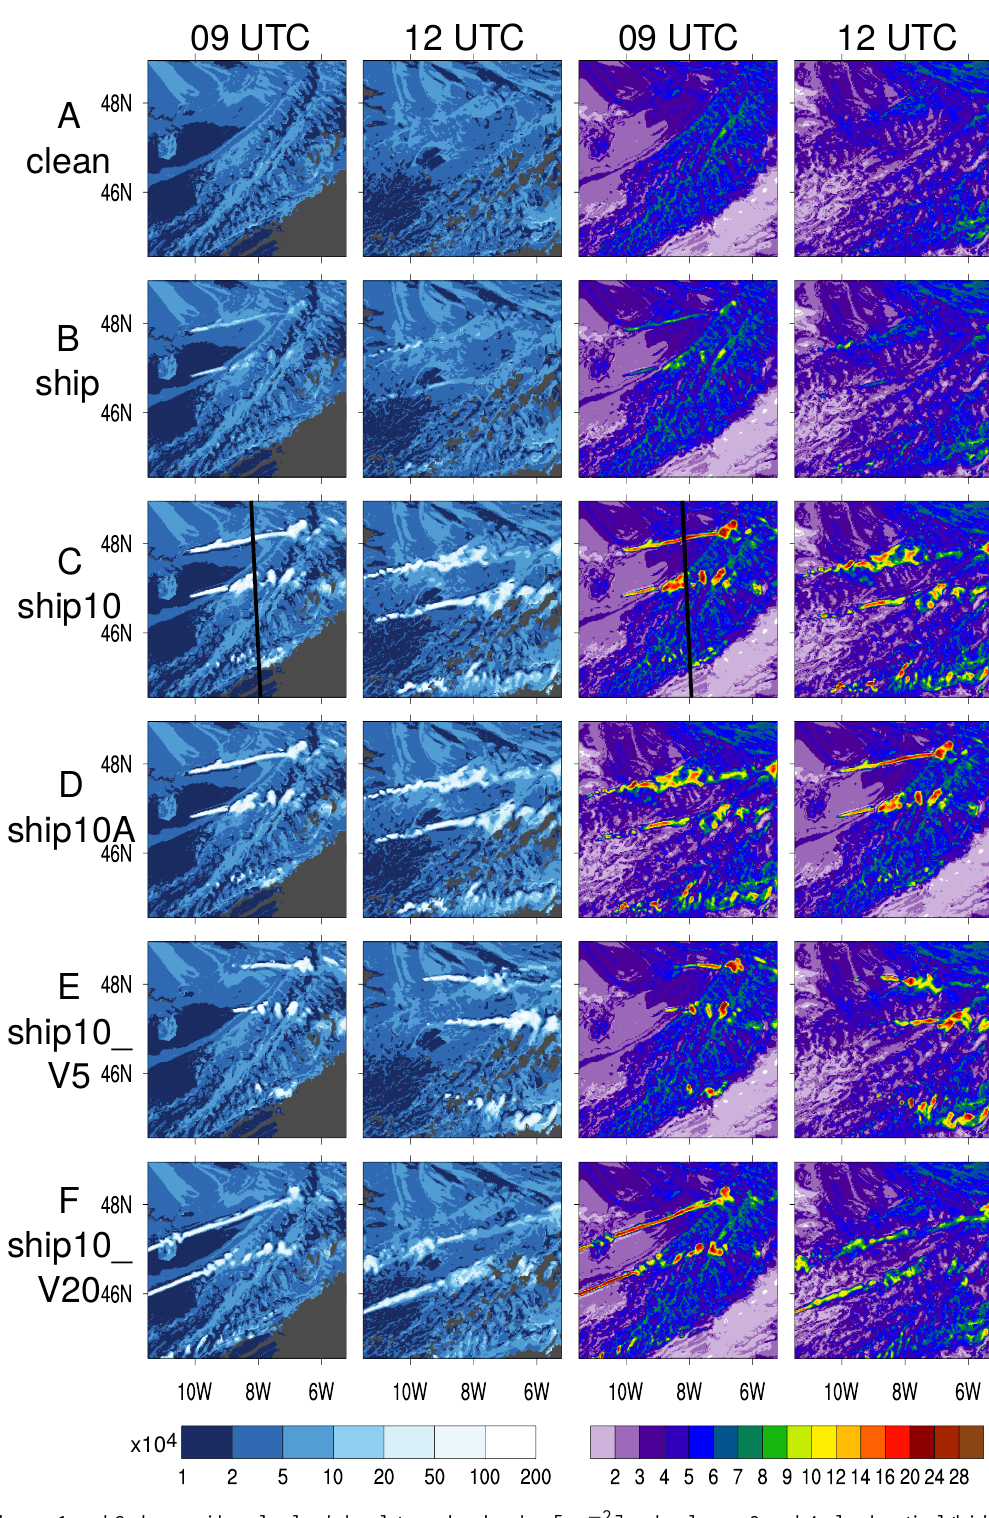
Figure 6. Columns 1 and 2 show grid-scale cloud droplet number burden [cm − 2 ] and columns 3 and 4 cloud optical thickness, including grid-scale and subgrid-scale contributions, at 09:00 and 12:00UTC respectively. Rows (a–f) show the following simulation results: (a) clean , (b) ship , (c) ship10 , (d) ship10A , (e) ship10_V5 and (f) ship10_V20 . Grey shaded areas in columns 1 and 2 denote regions of missing grid-scale